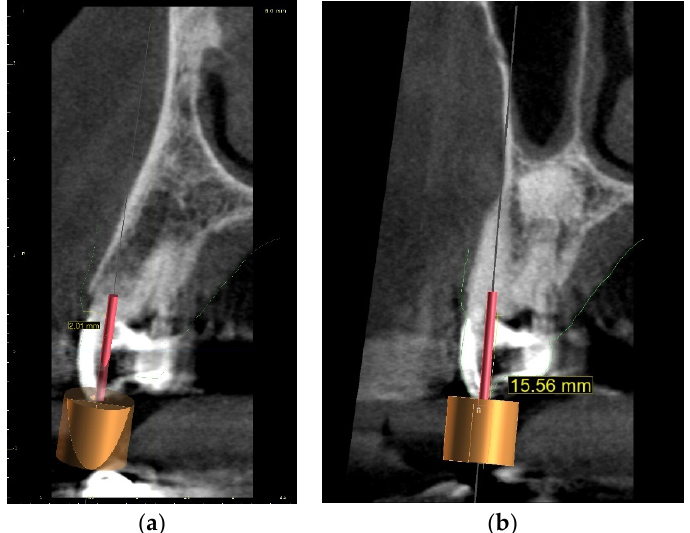
Figure 20. CBCT image presenting ( a ) virtual implant positioned through the centre of the buccal root, preserving a safe amount of the tooth’s hard tissues; ( b ) guide tube designed to reach the bottom of the chamber after 15.5 mm. In the lateral dentition area, short guide tubes may ensure more space for the drill.